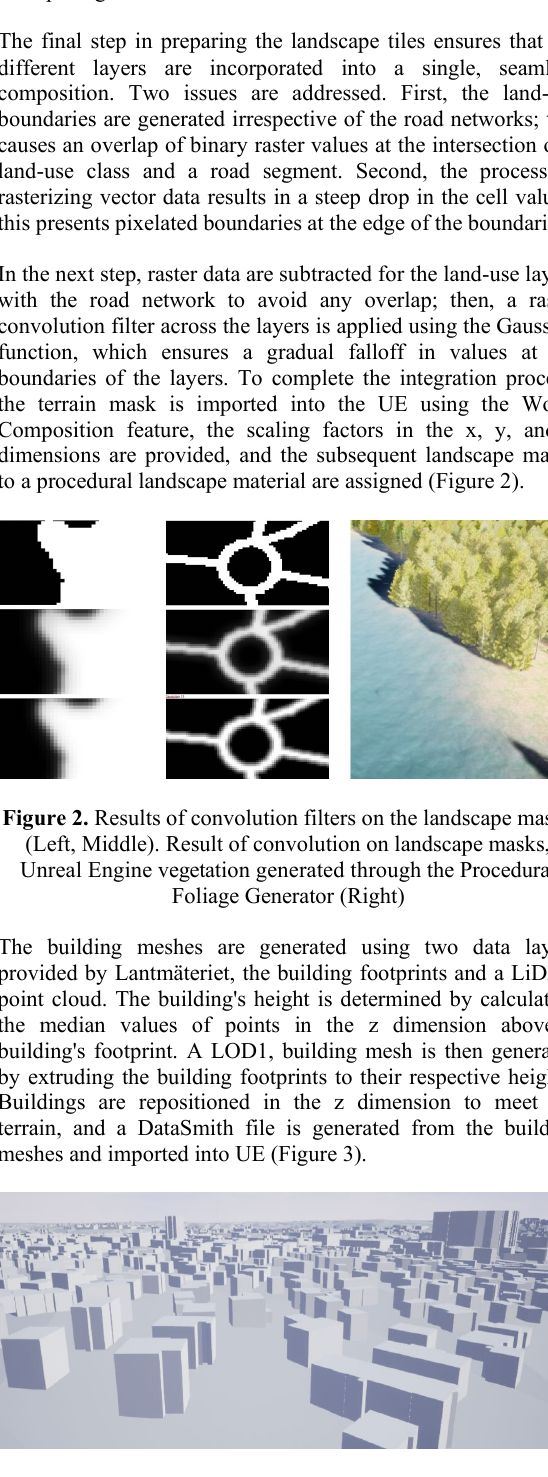
Figure 3. Level of Detail 1 meshes within Unreal